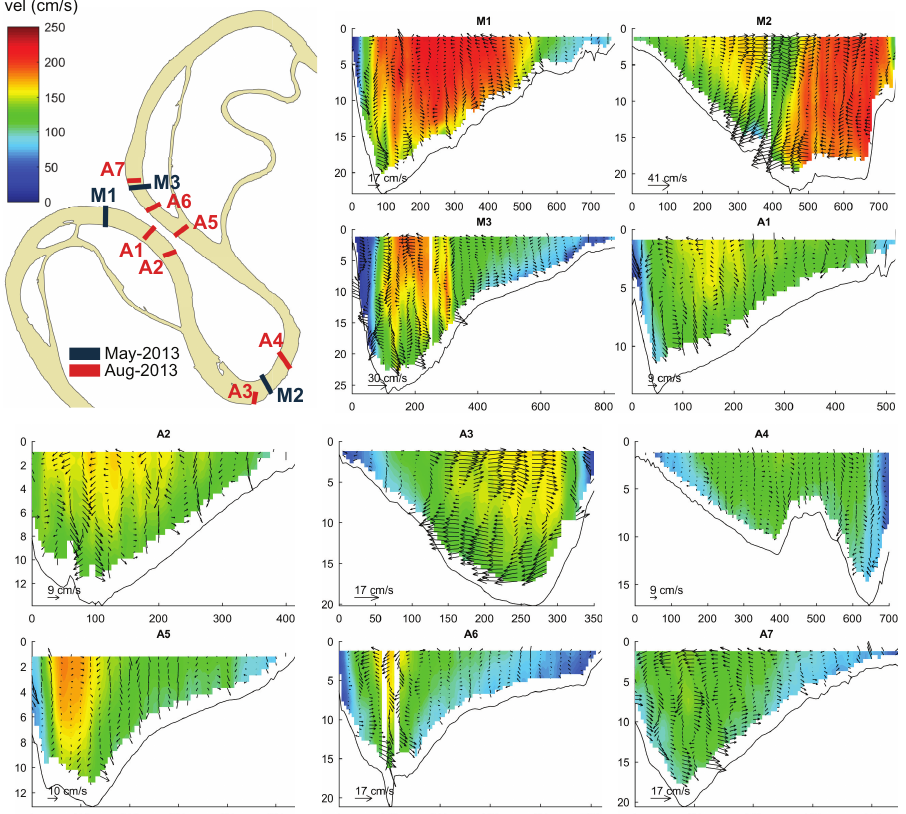
Figure 7. Velocity measurements of 2013 along the JH bend. The vectors represent the secondary flow using the Rozovskii decomposition, while the contours represent the velocity magnitude. M: May and A: August. May’s water discharges (Q (m 3 /s)) are 14,749.3 (M1), 17,034.6 (M2), and 12,999.4 (M3). Au- gust’s water discharges (Q (m 3 /s)) are 4947.4 (A1), 4670.3 (A2), 5449.8 (A3), 6018.5 (A4), 4745.4 (A5), 5162.7 (A6), and 5127.8